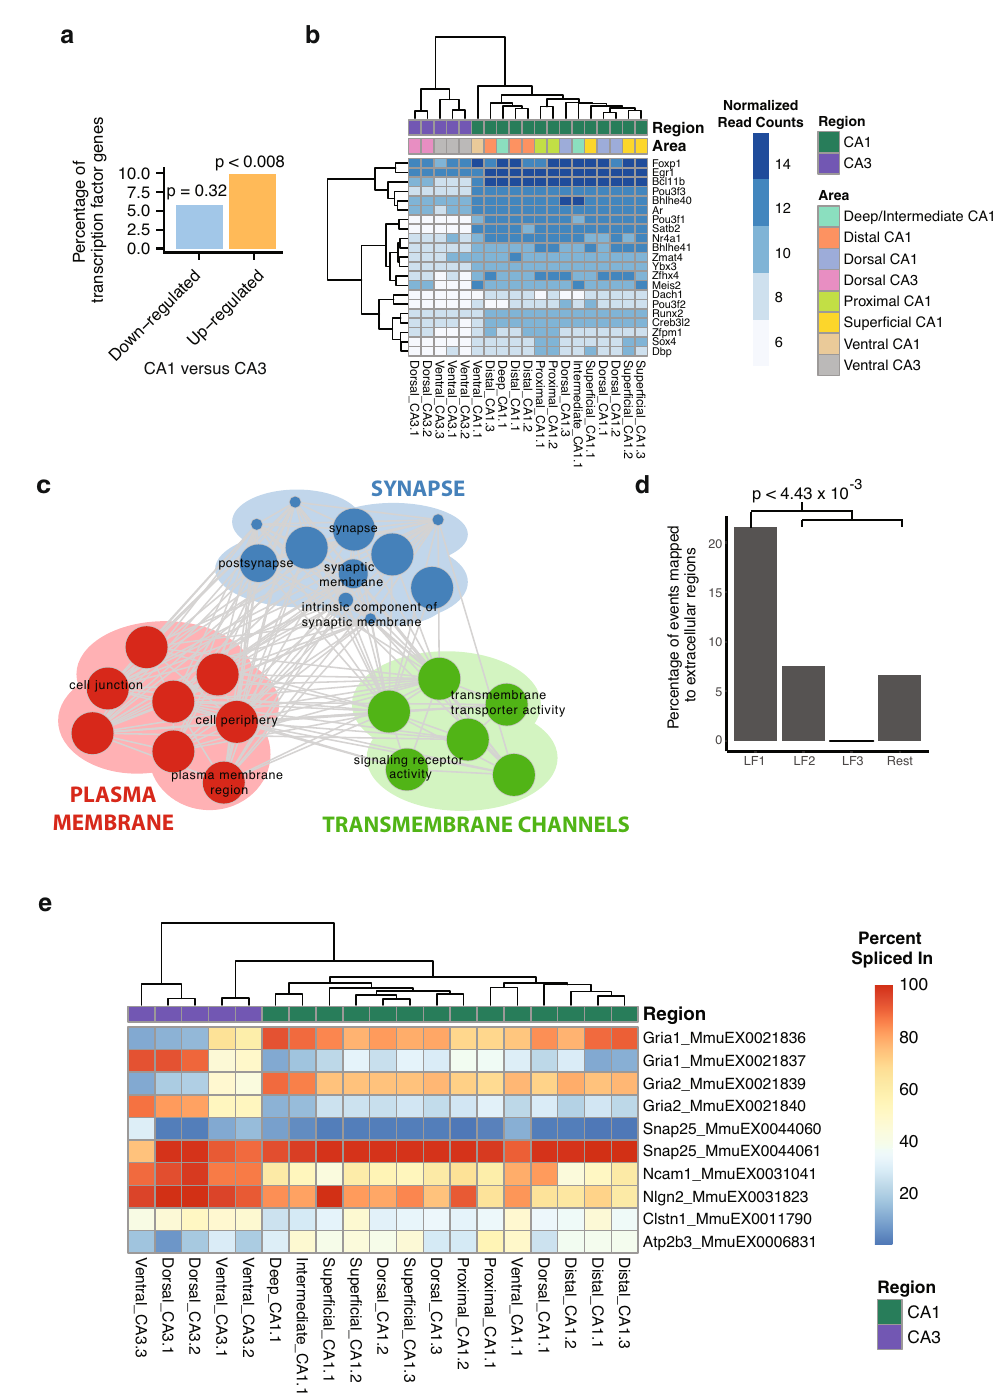
Fig. 2 AS in LF1 distinguishes CA1 and CA3 sub fi elds. a Bar-plot summarizing the proportion of down- and upregulated genes in CA1 versus CA3 that are annotated transcription factors. Among 298 upregulated genes, the overlap with transcription factors ( n = 27) was statistically signi fi cant ( p = 0.00844, hypergeometric test). b Heatmap showing normalized read counts of the upregulated transcription factors (rows) for each sample (columns). Each sample is annotated according to region and area (horizontal bars above heatmap). The fi nal number in name indicates the replicate number. c Enrichment map 74 for GO, REACTOME and KEGG functional categories of genes from the top AS events with the largest absolute LF1 loading. Node size is proportional to the number of genes associated with the GO category, and edge width is proportional to the number of genes shared between GO categories. d Overlap of AS events mapped to extracellular regions for each latent factor ( p = 4.43 × 10 − 3 , two-sided Fisher ’ s exact test). e Heatmap showing the percent spliced-in (PSI) values of top AS events from LF1. These events include pairs of mutually exclusive cassette exons in Gria1 and Gria2 (rows), which are differentially spliced between CA1 and CA3 regions (compare left CA3 cluster with right clusters). Row names consist of gene name and VAST-TOOLS event IDs. Sample naming is as in Fig.